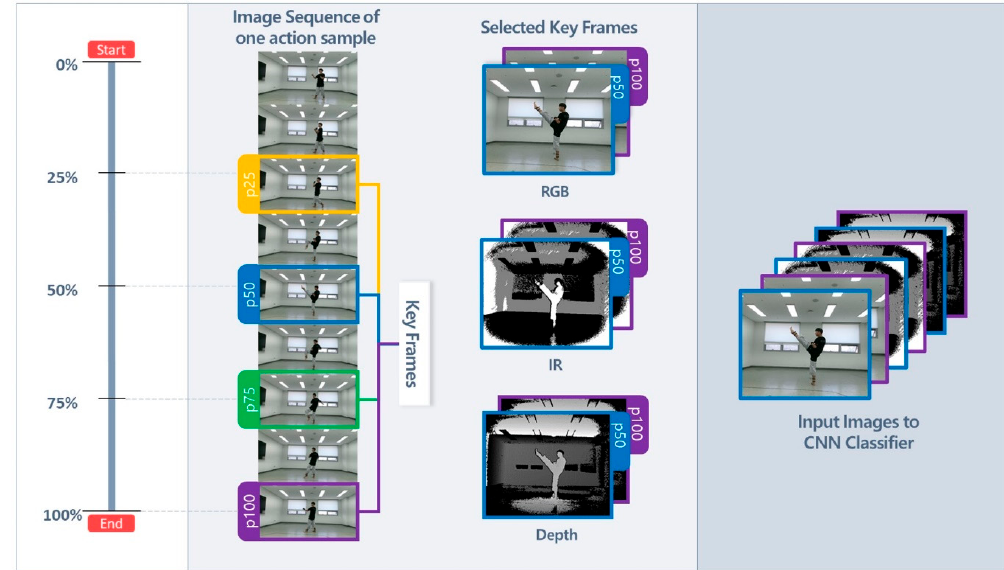
Figure 8. Process of constructing the key frame-based multimodal input images for the convolutional neural network (CNN) classifier.